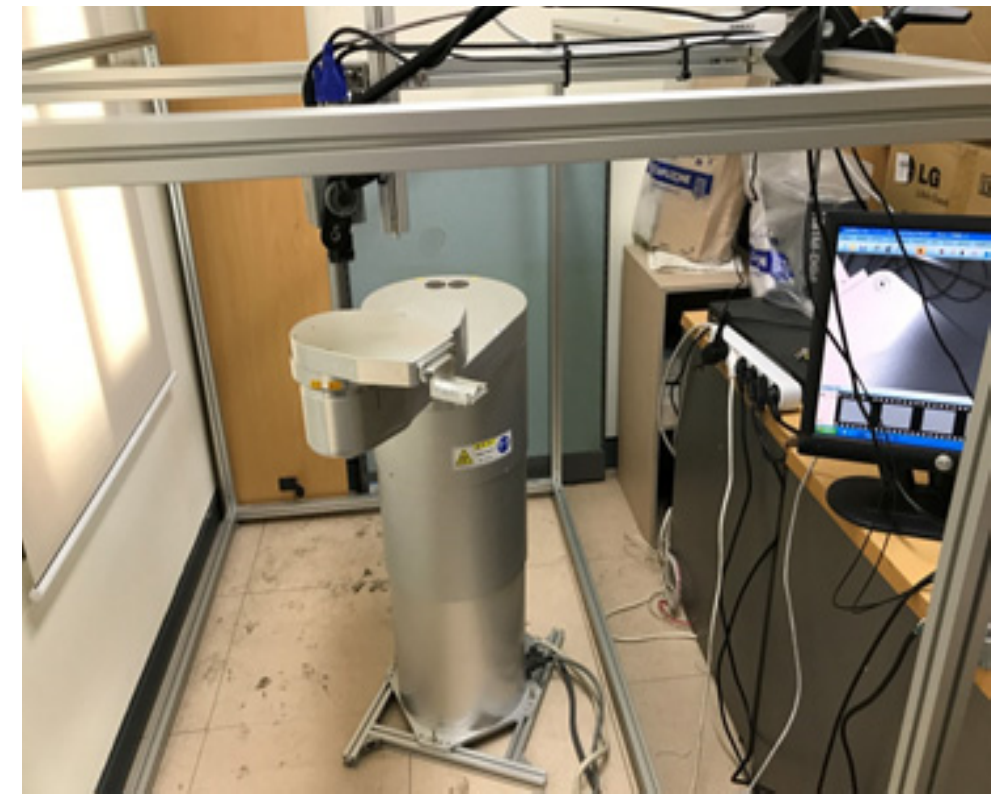
Figure 1. Wafer transfer robot and equipment setting for data acquisition.